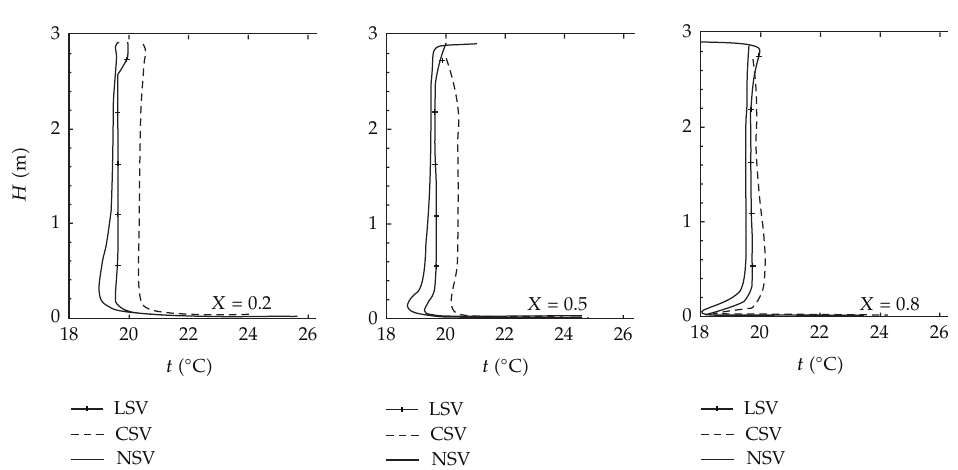
Figure 3: The temperature distributions at di ff erent X locations for the cases shown in Figure 2.